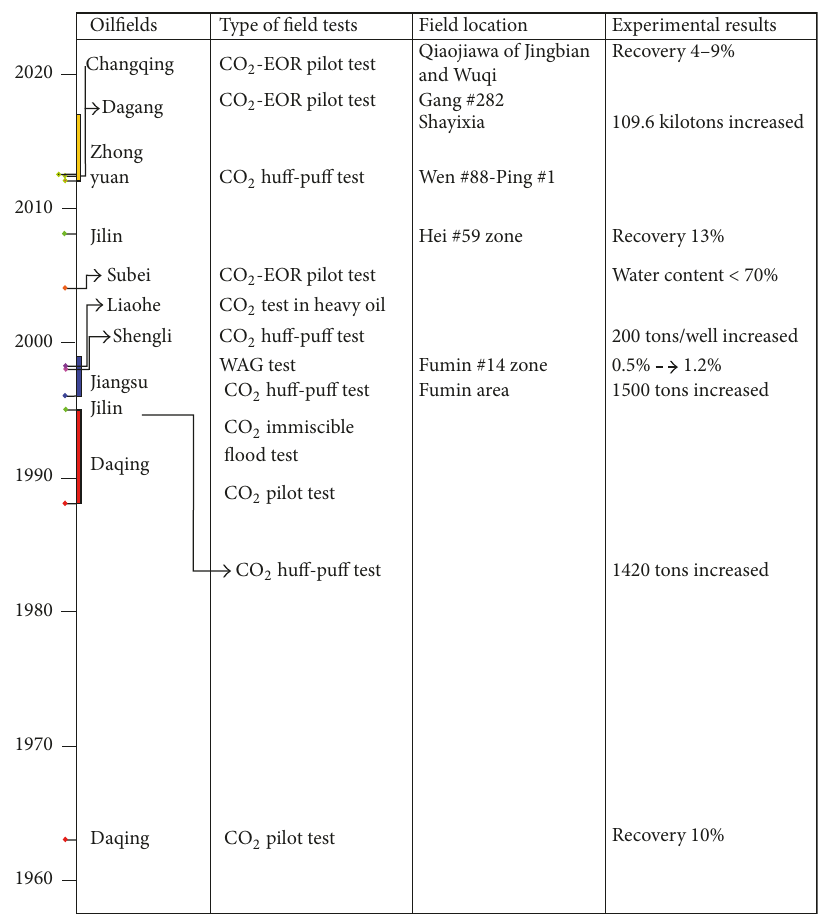
Figure 6: Development of CO 2 -EOR pilot tests in several oilfields in China since the